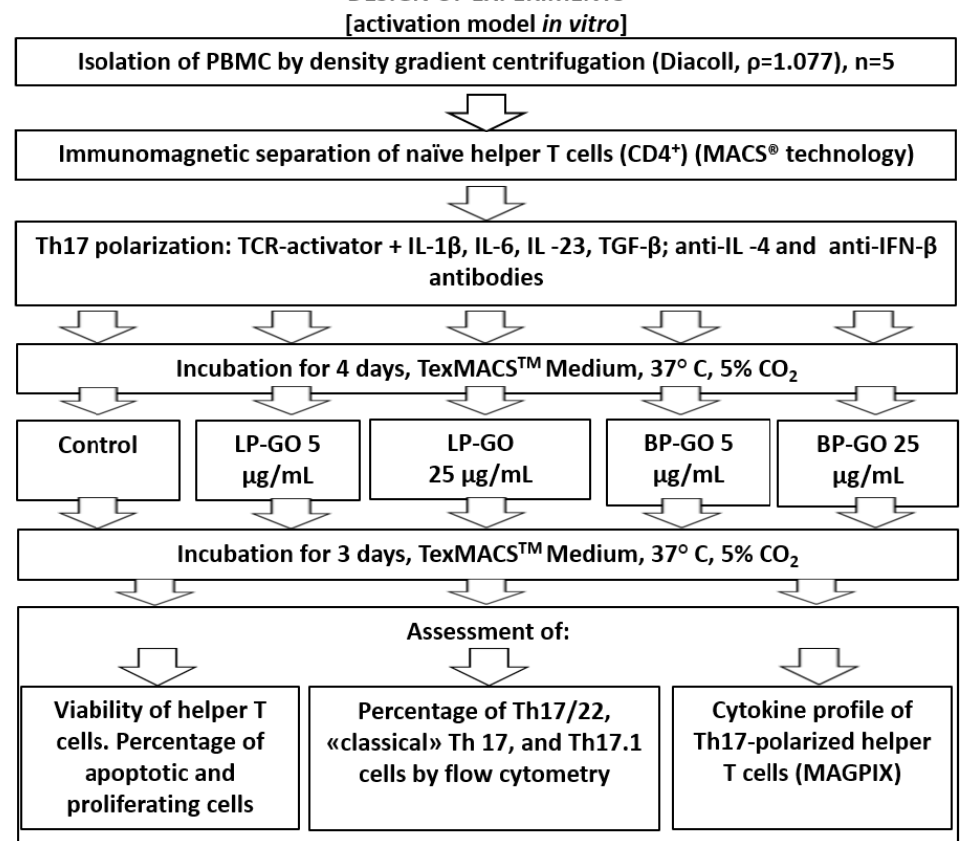
Figure 1. Experimental design.